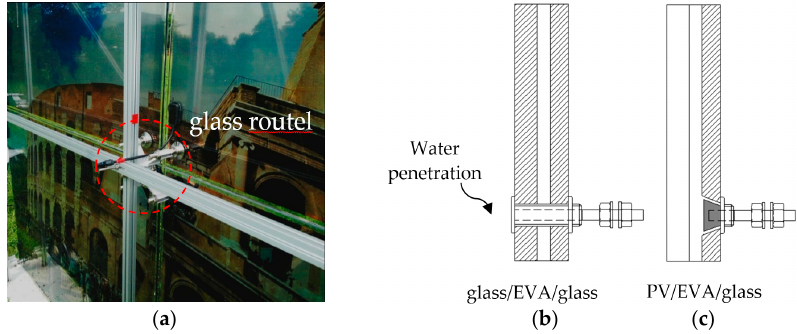
Figure 9. ( a ) Installation of artist PV modules with glass routels, and a comparison of the routels used in ( b ) traditional glass; and ( c ) artist PV modules. EVA: ethylene vinyl acetate.